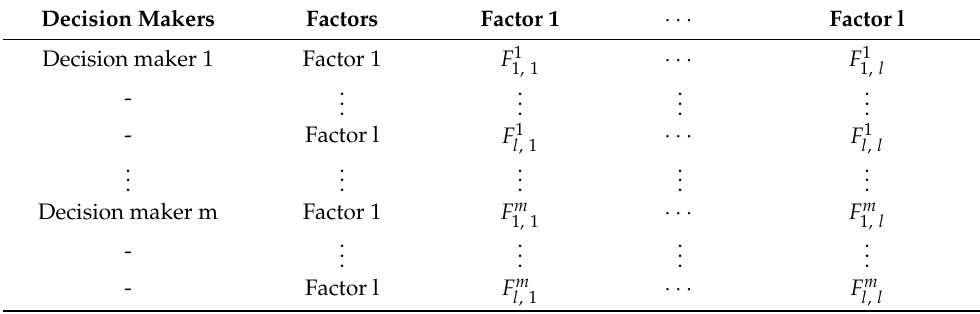
Table 6. Pairwise comparison of factors (geo-based data) concerning components of decision maker. Decision